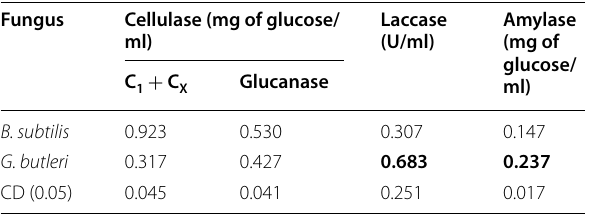
Table 1 Production of cellulase, laccase, and amylase by G. butleri and B. subtilis